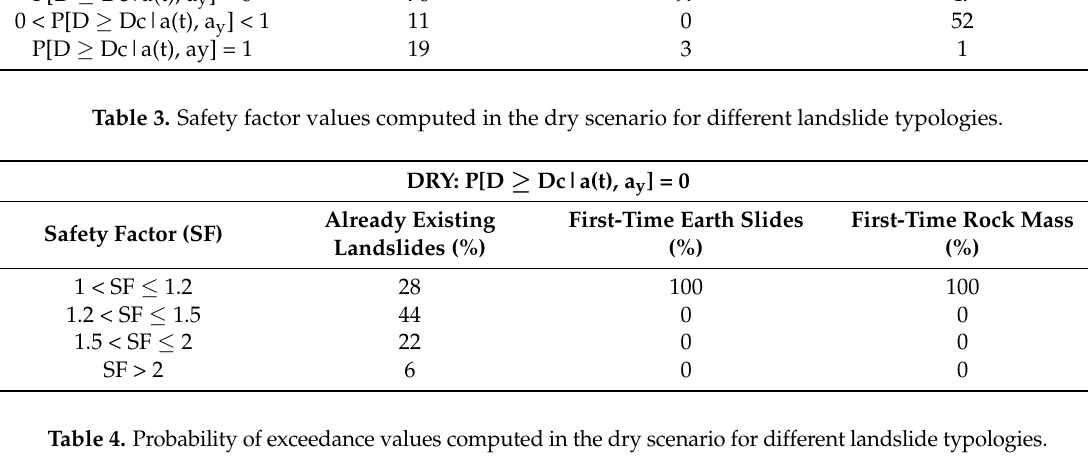
Table 4. Probability of exceedance values computed in the dry scenario for different landslide typologies.